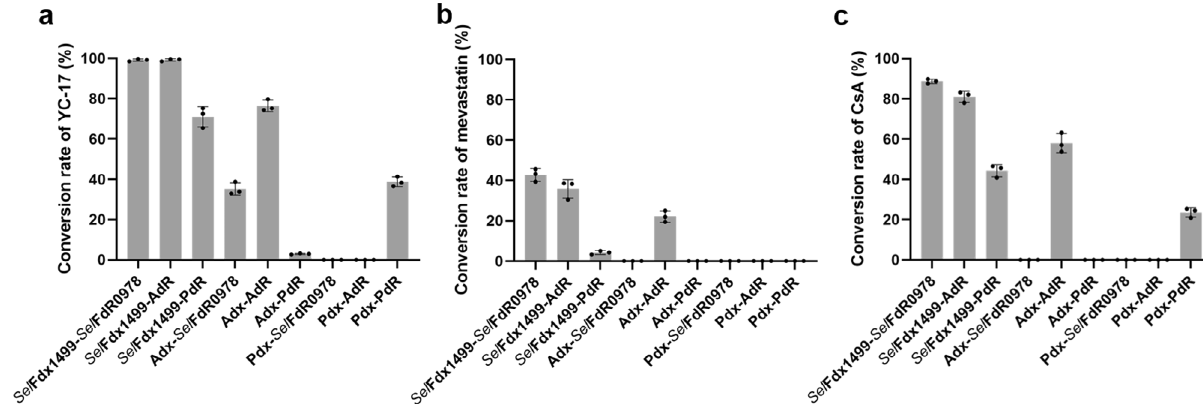
Fig. 2 In fl uence of the selection of redox partner on P450 activities. The catalytic activities of PikC ( a ), P450sca-2 ( b ), and CYP-sb21 ( c ) when supported by nine different combinations of redoxin and redoxin reductase. All the experiments were carried out in triplicate. The error line represents the standard deviation. P values in each groups were calculated with single factor ANOVA analysis, and all P values were